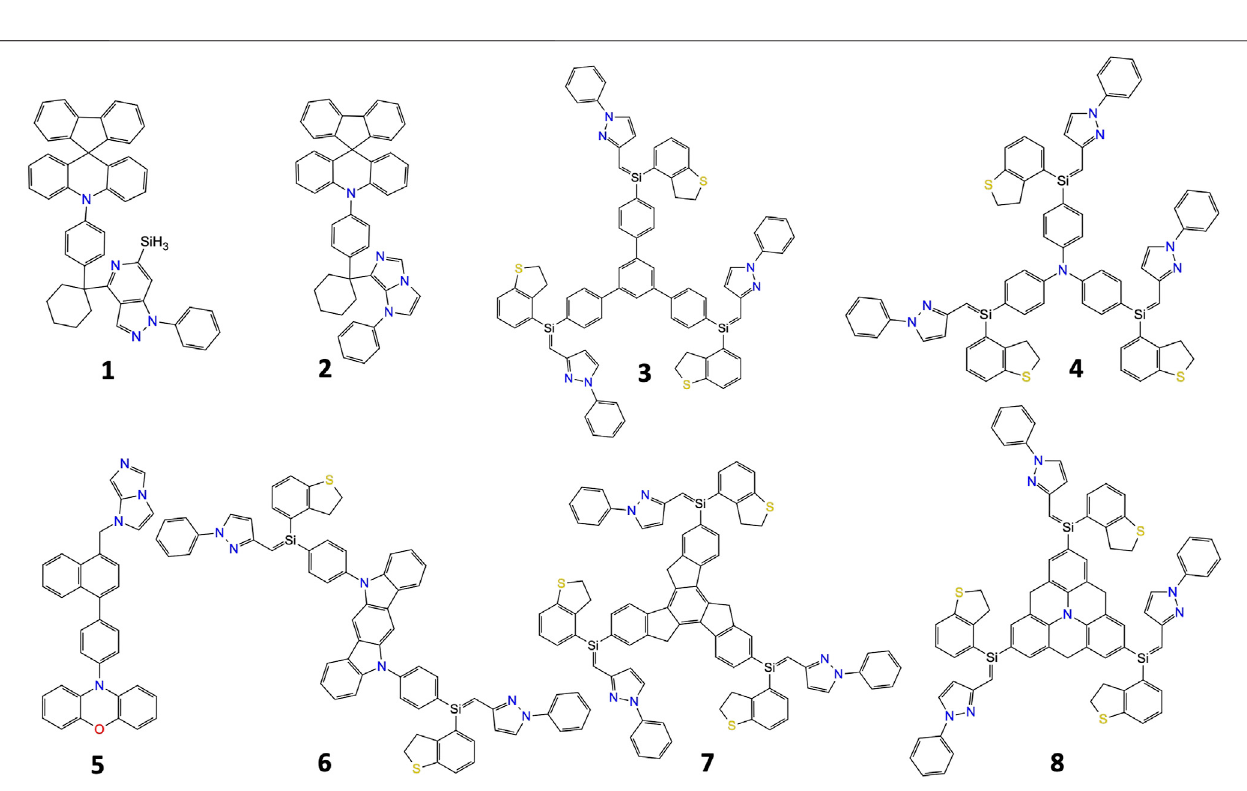
FIGURE 4 | Some of the materials candidates with top MPO scores for the hole transport